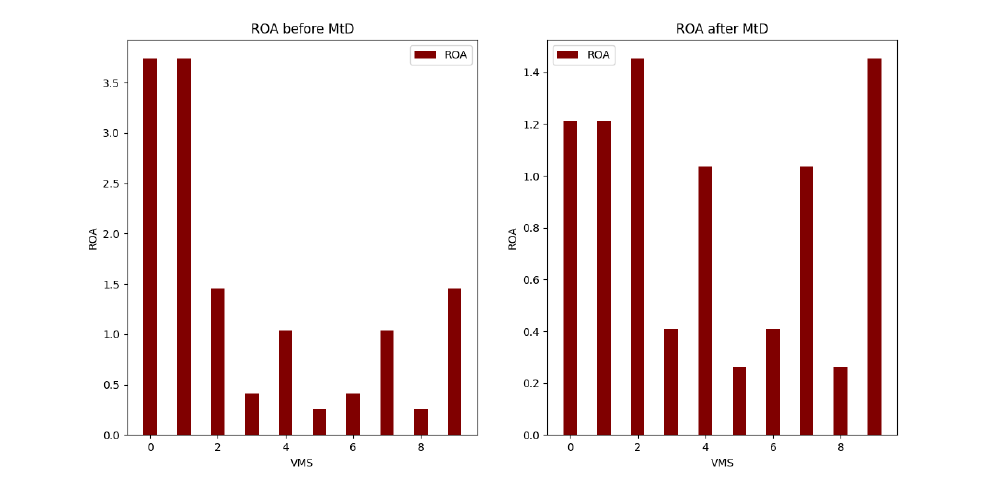
Figure 9. Comparison of ROA of VMs before and after applying shuffle and diversity